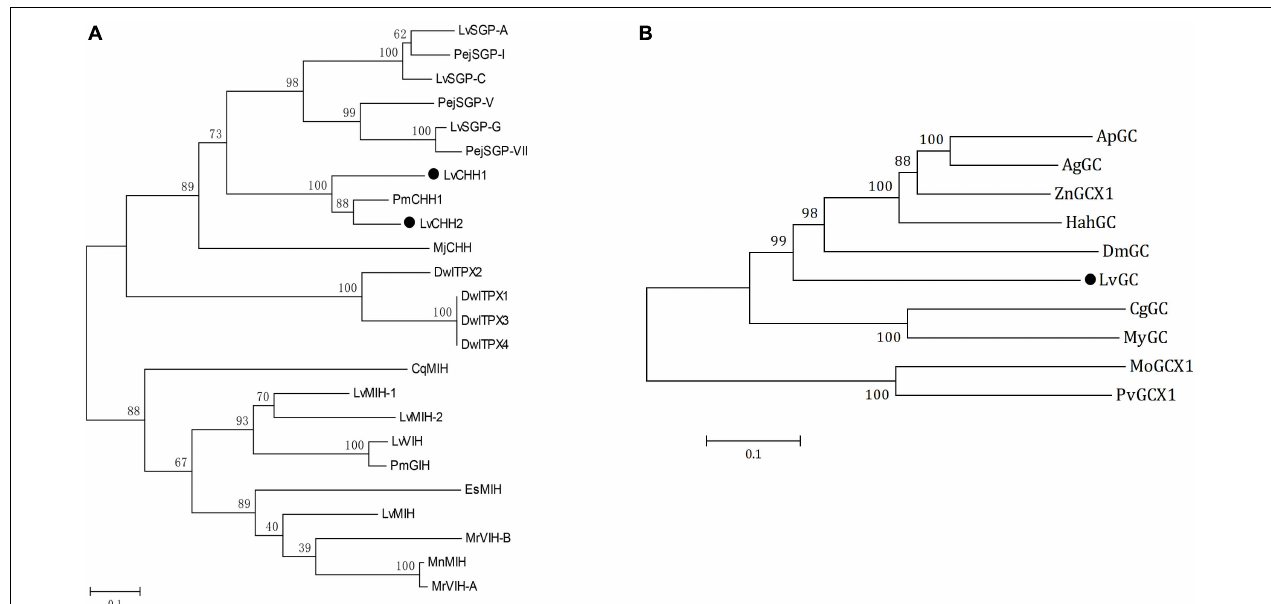
FIGURE 2 | Phylogenetic analyses of CHHs and GCs. (A) Phylogenetic analysis of LvCHH1 and LvCHH2 (solid circle) from Litopenaeus vannamei and homologous proteins from other species ( Drosophila willistoni , DwITPX1/XP_015034465, DwITPX2/XP_015034467, DwITPX3/XP_002062858, DwITPX4/XP_023037604; Penaeus japonicus , PejSGP-I/BAA22560, PejSGP-V/BAA22561, PejSGP-VII/BAA22562; Marsupenaeus japonicus , MjCHH/BAE78493; P. monodon , PmCHH1/AAQ24525, PmGIH/AMQ67879; C. quadricarinatus , CqMIH/ACX55057; Eriocheir sinensis , EsMIH/ABC68517; M. nipponense , MnMIH/AIP90070; M. rosenbergii , MrVIH-A/AAL37948, MrVIH-B/AAL37949; L. vannamei , LvSGP-A/BBA57870.1, LvSGP-C/BBA57874.1 LvSGP-G/BBA57873, LvMIH/ATN45407, LvMIH-1/ABD73291, LvMIH-2/ABD73292, LvVIH/AGX26044). (B) Phylogenetic analysis of LvGC (solid circle) from L. vannamei and homologous proteins from other species ( Agrilus planipennis , ApGC/XP_025832416; Anoplophora glabripennis , AgGC/XP_023312344; Zootermopsis nevadensis , ZnX1/XP_021915041; Halyomorpha halys , HahGC/XP_014284869; Daphnia magna , DmGC/KZS20192; Crassostrea gigas , CgGC/EKC28433; Mizuhopecten yessoensis ,